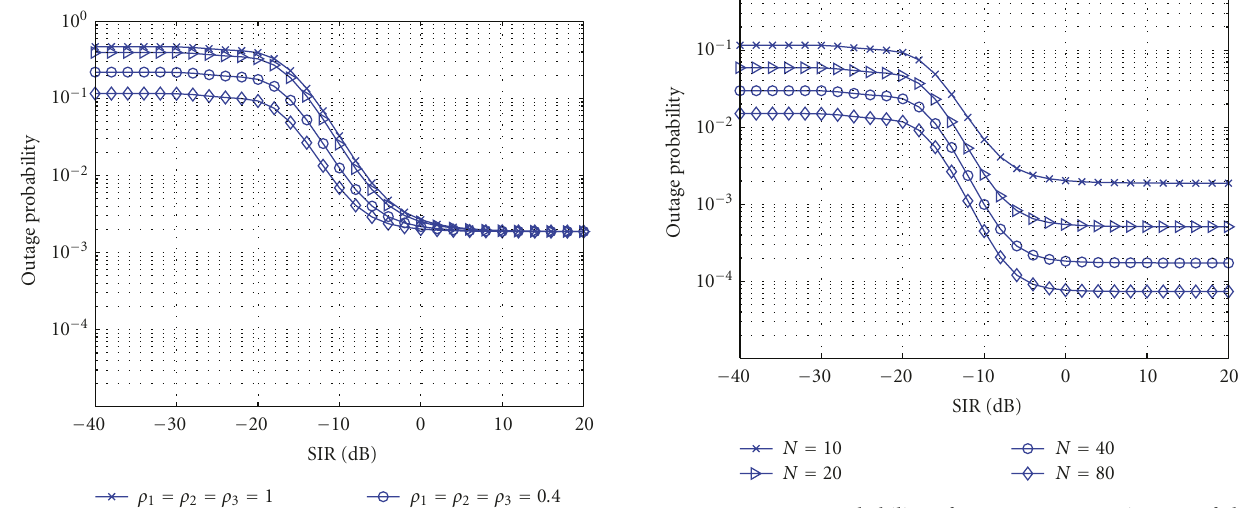
Figure 9: Outage probability of a DS/FH system, impact of the number of hopping channels, the number of antenna elements M = 2, processing gain G DS = 50, the number of users K = 40, the number of interferers is J 1 = 1, J 2 = 2, J 3 = 3, duty cycles of interferes are ρ 1 = ρ 2 = ρ 3 = 0 . 2, SNR Γ N = 100 dB, the number of multiple path L = 3, decay factor δ = 0, and protection ratio r th = 3